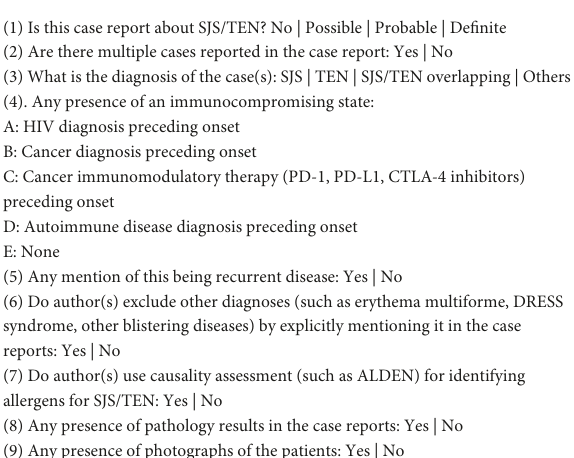
TABLE 2 Questions answered by annotators for each case